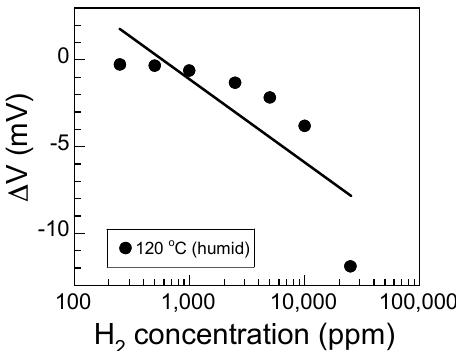
Figure 4. The relationship between sensor response and the log of the H 2 concentration in humid air at 120 °C. The solid line shows the least-squares linear fit.